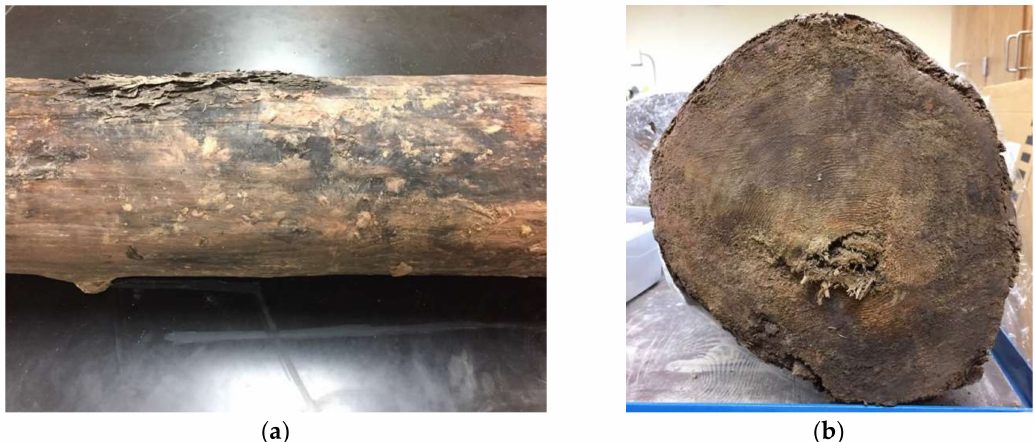
Figure 1. Subfossil spruce wood ( Picea ) from the Two Creeks Buried Forest in northeastern Wisconsin, USA showing no significant desiccation cracking, despite storage in the laboratory for over two years in plastic wrap. Locality is the Ebben Quarry near Green Bay, Wisconsin (44.440279 ◦ N, 88.173981 ◦ W) and is a confirmed Two Creeks site by Hooyer and Mickelson [41]. ( a ) View of outside of log. Scaly portion at top left is a remnant of the original bark. ( b ) View of transverse section showing lack of desiccation cracking. Log diameter is 26